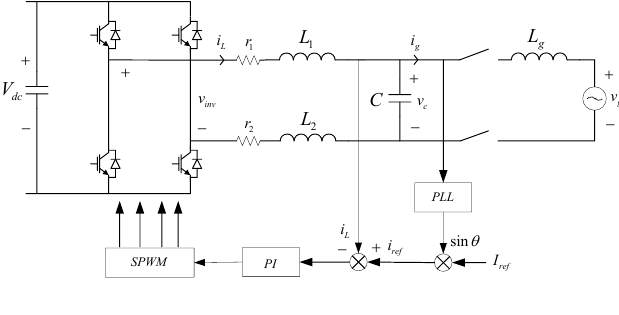
Fig. 1. Single-phase grid connected inverter with LC filter